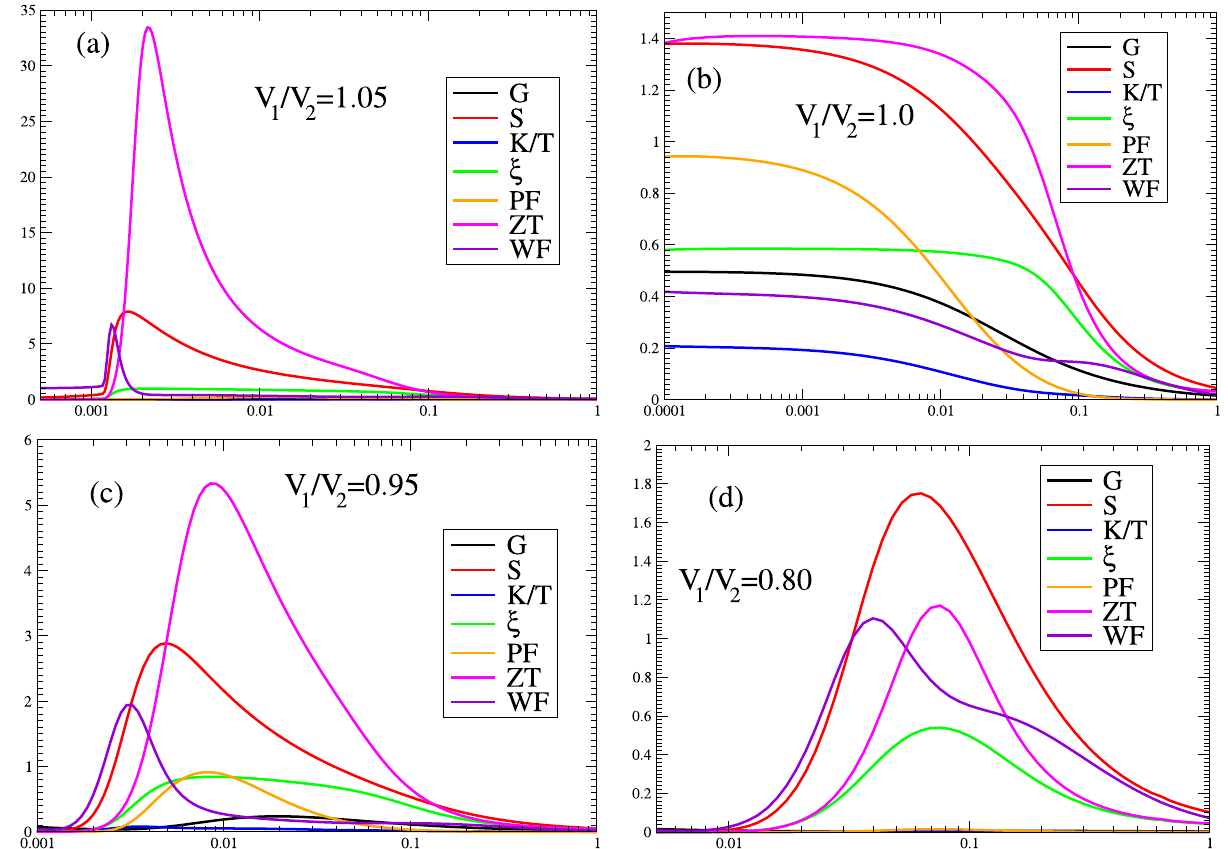
Figure 11. Temperature activated thermoelectric properties for different values of the hybridization V 1 / V 2 : ( a ) 1.2 ; ( b ) 1.0 ; ( c ) 0.8 ; ( d ) 0.5